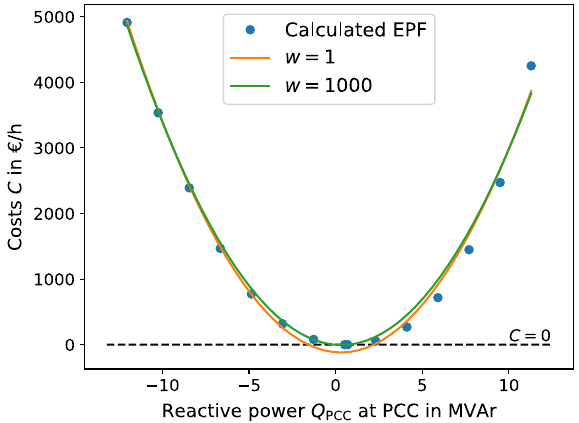
Fig. 4 Calculation result of an EPF and its quadratic approximation with different methods for a complete